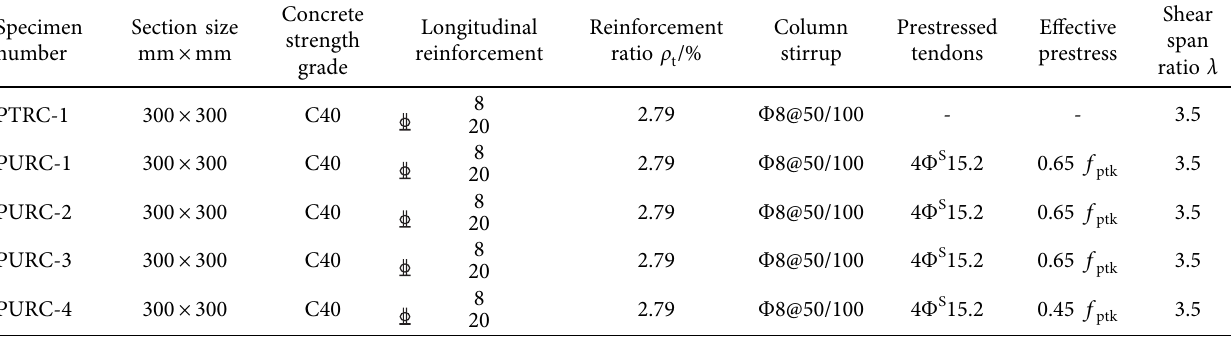
Table 1: Design parameters of specimens.